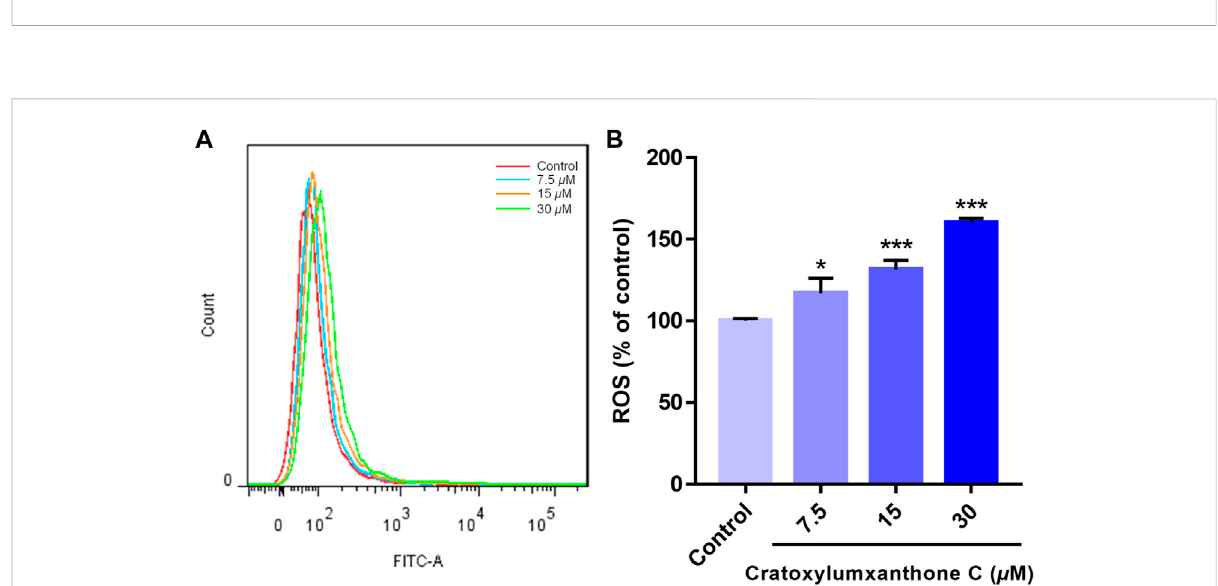
FIGURE 4 Cratoxylumxanthone C increased ROS production in A549 cells. A549 cells were treated with different concentrations (7.5, 15, and 30 μ M) of cratoxylumxanthone C for 48 h. Cells were stained with DCFH-DA, and analyzed by fl ow cytometer. (A) Flow cytometric analysis of A549 cells after treated with different concentrations of cratoxylumxanthone C. (B) Histogram of relative ROS level compared with control group. The results are expressed as means ± SD. *p < 0.05 and ***p < 0.001 versus control